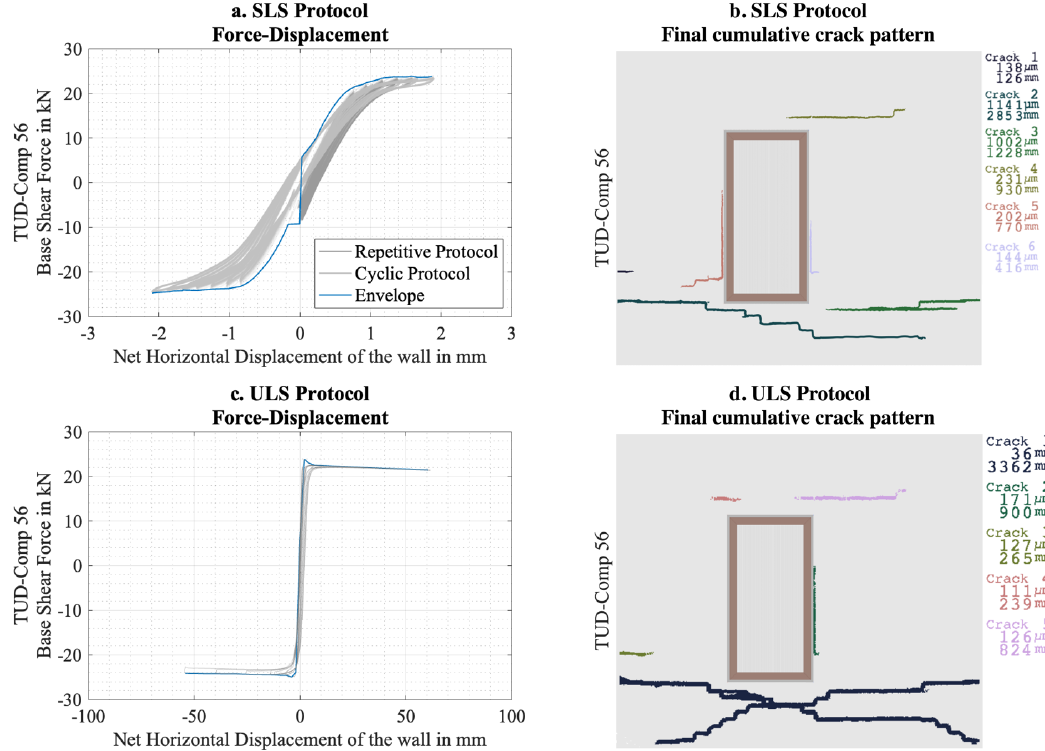
Figure 11. Results obtained on the strengthened wall (TUD-Comp56) in terms of base shear force versus net horizontal displacement curve and final cumulative crack pattern for the SLS and ULS protocol.